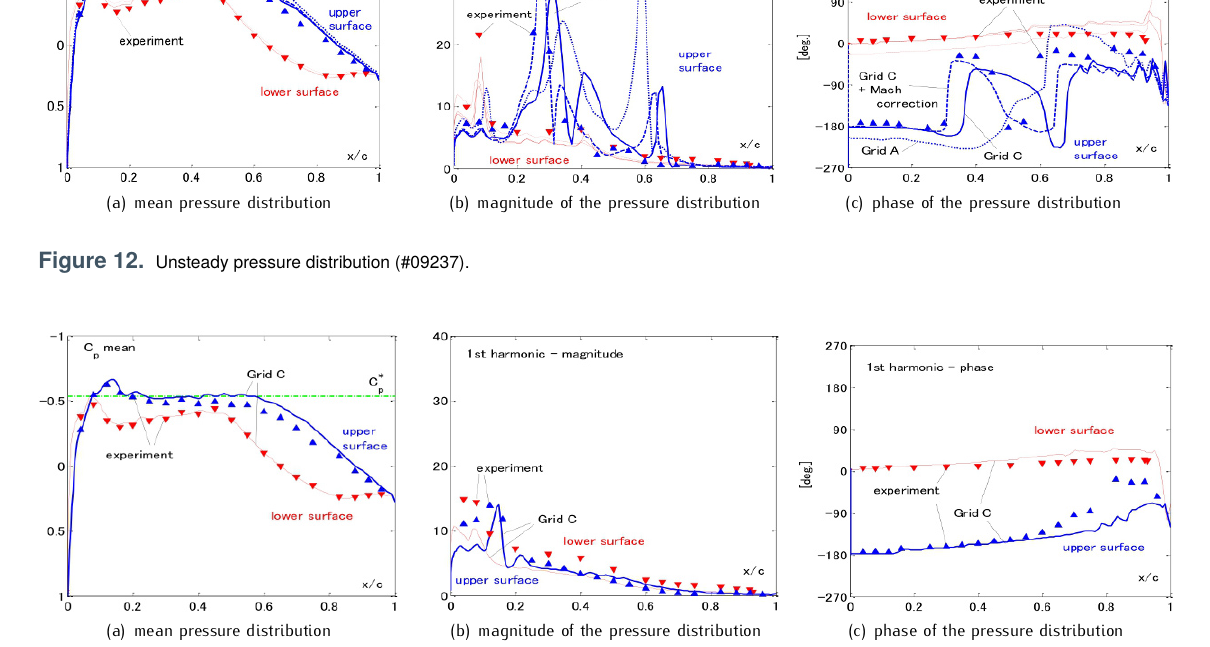
Figure 13. Unsteady pressure distribution